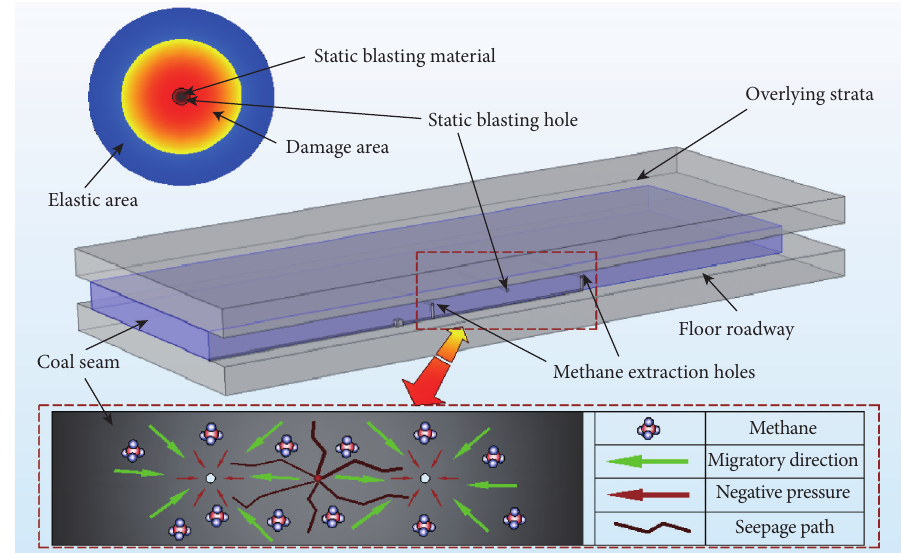
Figure 1: Mechanism of static blasting action during coalbed methane